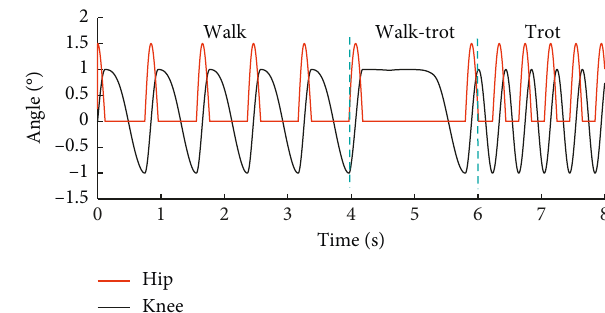
Figure 9: The relationship between the hip and the knee rotation angle in the walk gait.